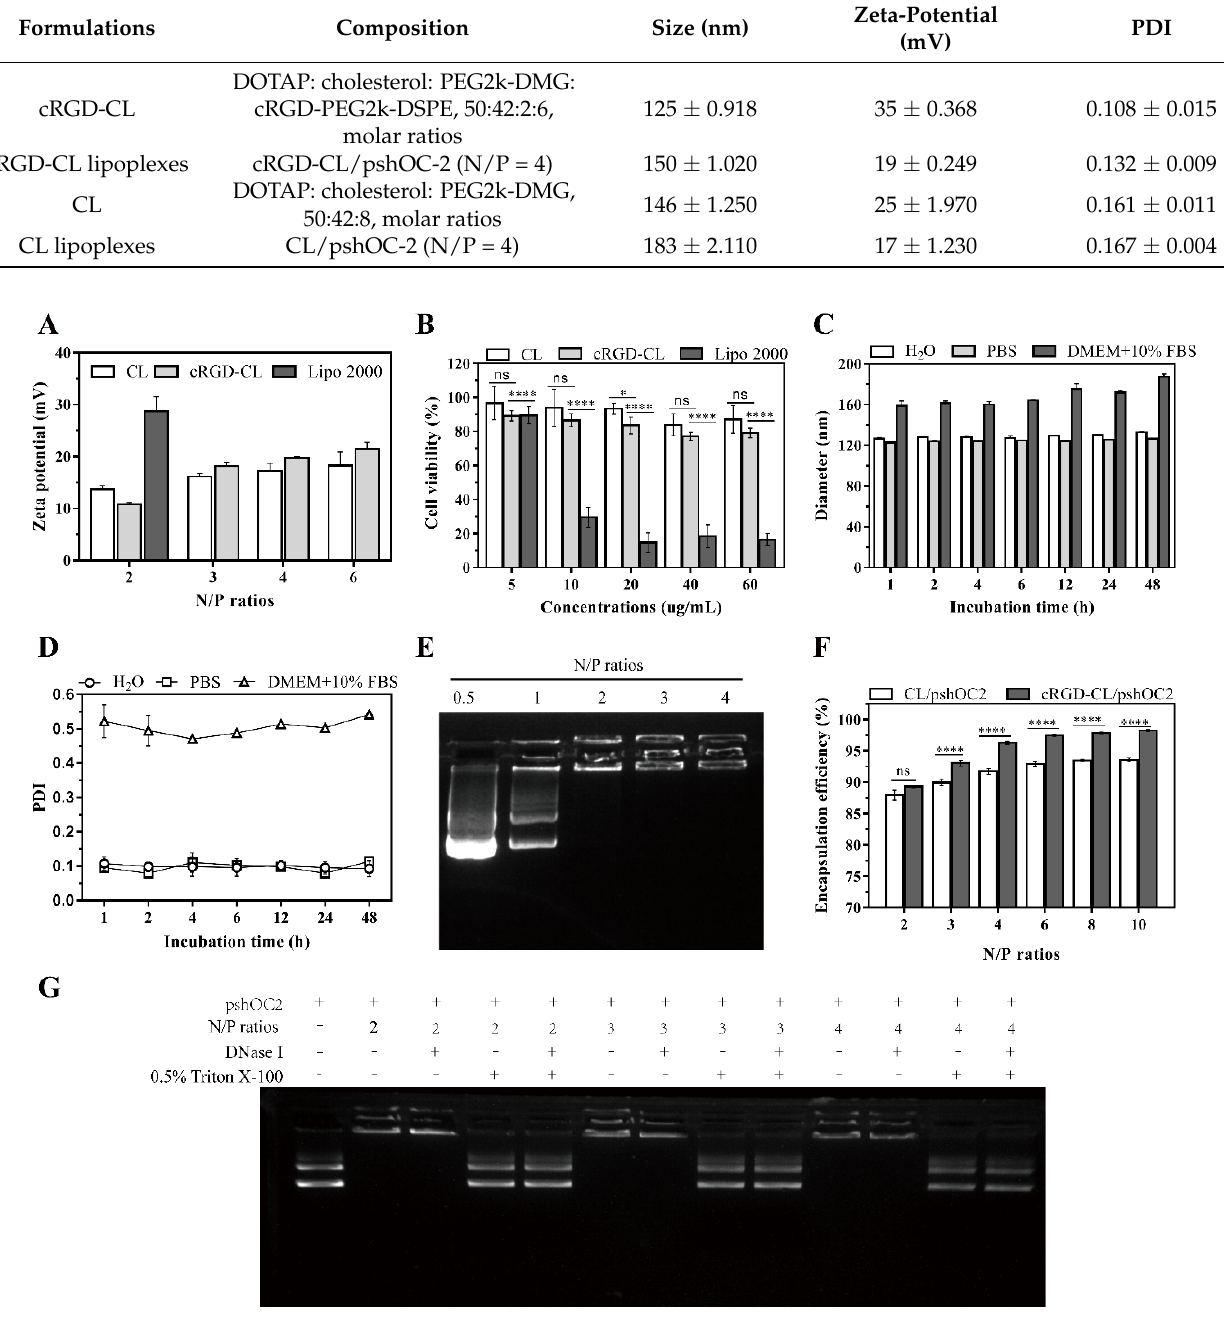
Table 2. Characterization of pshOC-2-delivered CLs.